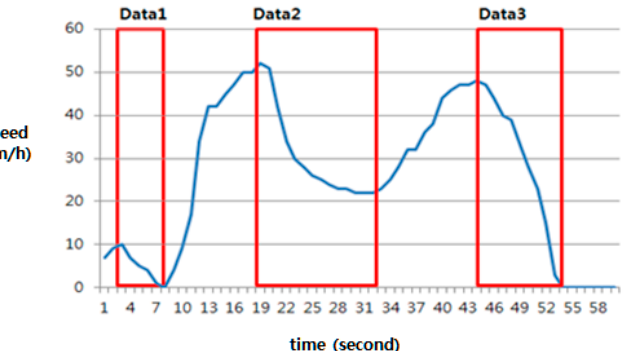
Figure 10. Various deceleration patterns, including sudden braking.